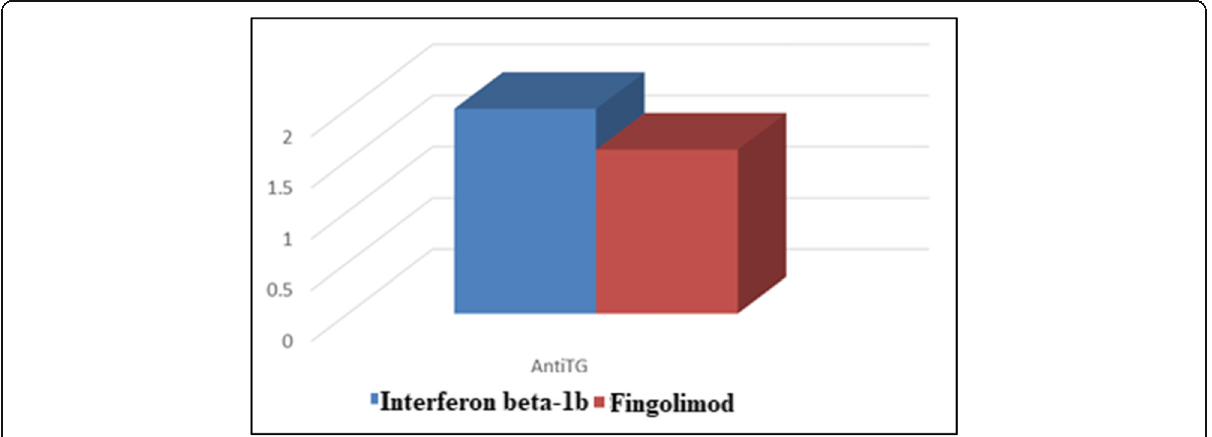
Fig. 4 The association between DMDs and levels of